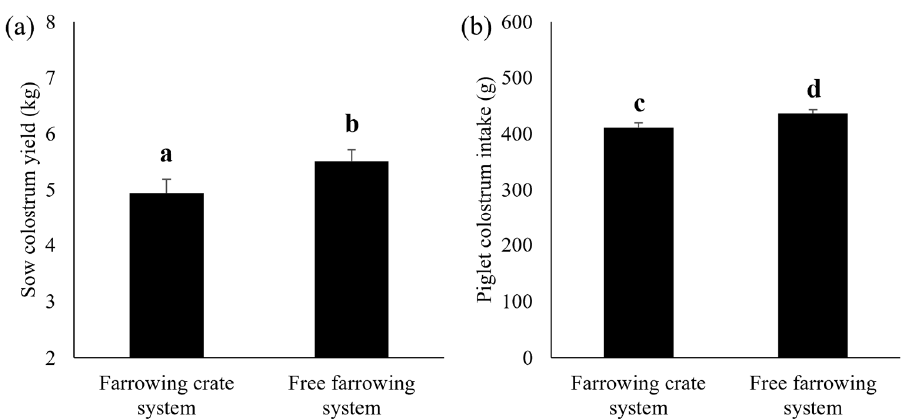
Figure 2. ( a ) Sow colostrum yield and ( b ) piglet colostrum intake for sows kept in the crate